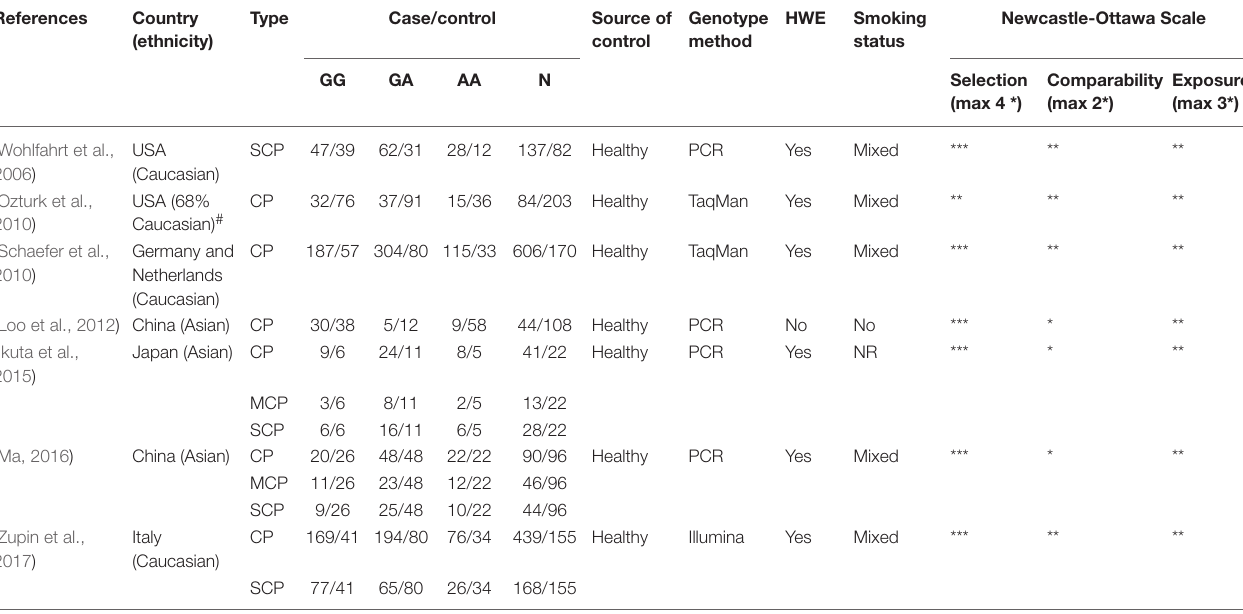
TABLE 1 | Characteristics, unadjusted data, and quality assessment results of included studies.